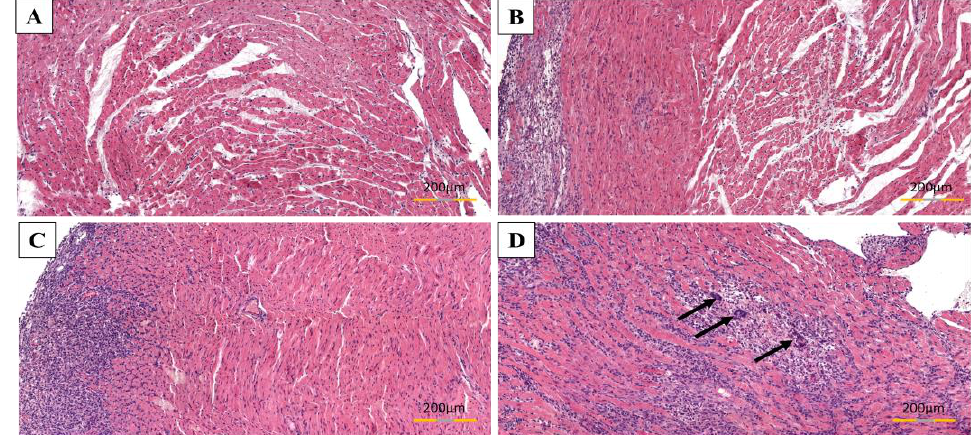
Figure 5. The acuteness of inflammation in rats ’ cardiac muscle subjected to EAM. Area of heart without inflammation ( A ), a mild degree of inflammation ( B ), a moderate degree of inflammation ( C ), severe degree of inflammation; arrows indicate multinucleated giant cells ( D ). HE stain.